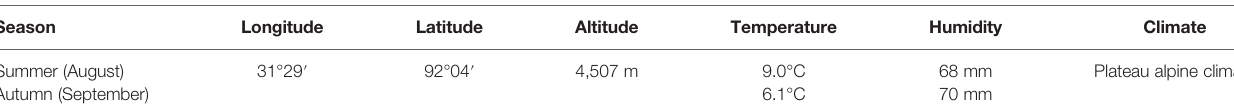
TABLE 2 | Factors in the sampling site of different seasons in tibet.